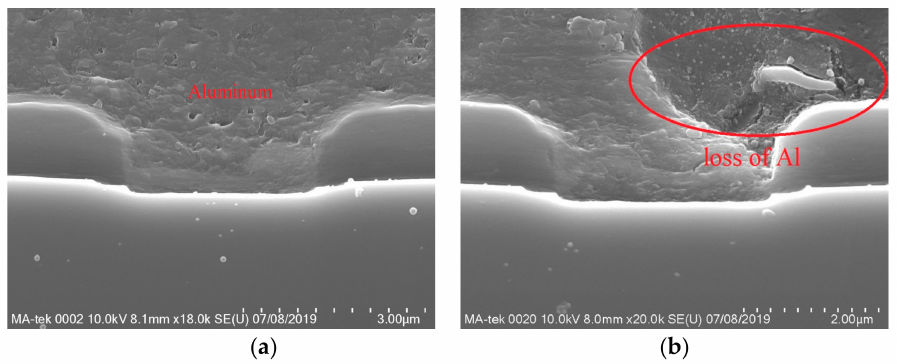
Figure 13. SEM images of C2M0160120D ( a ) before, ( b ) after the device